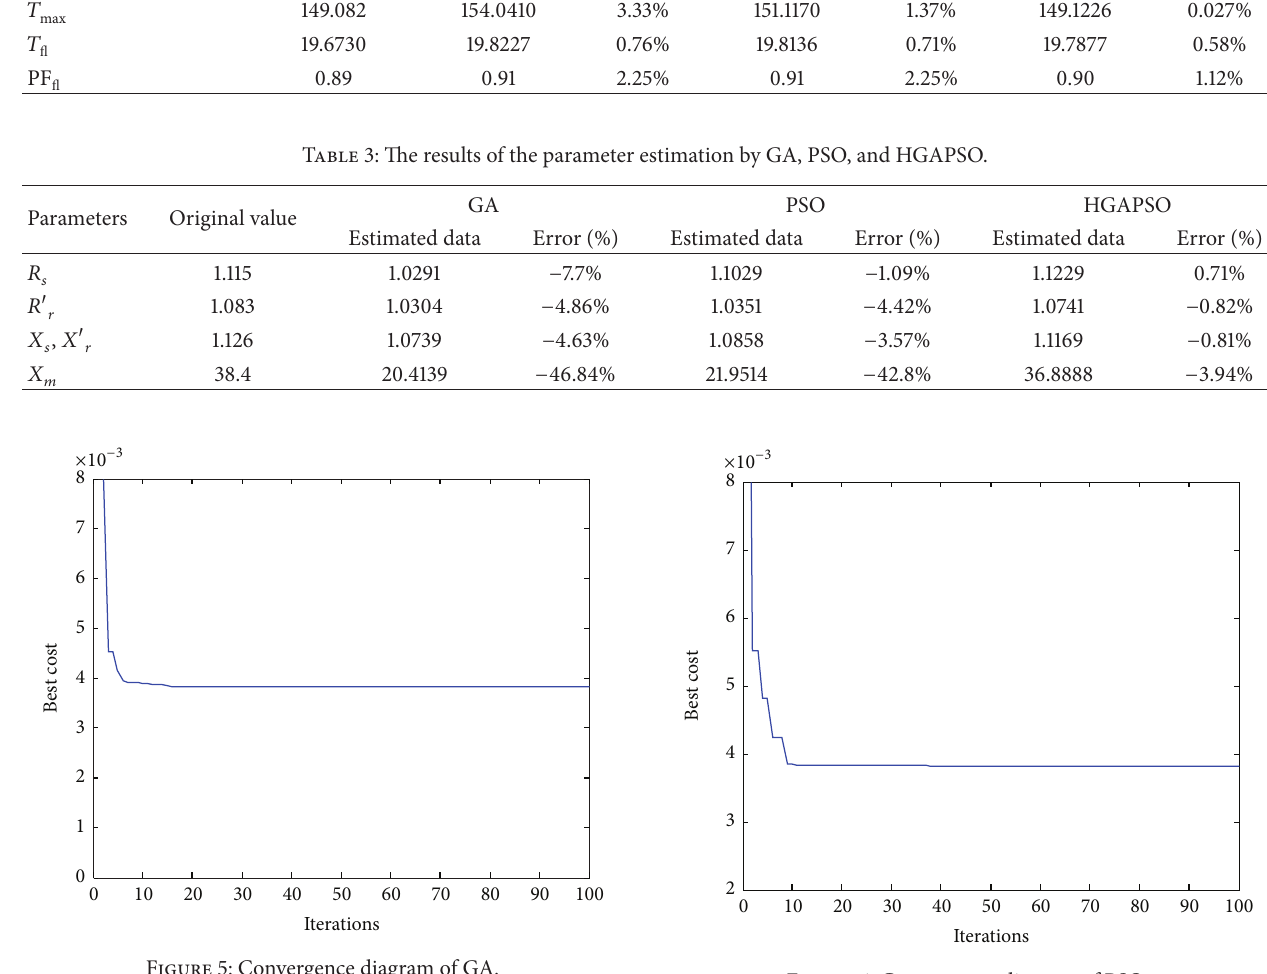
Figure 6: Convergence diagram of